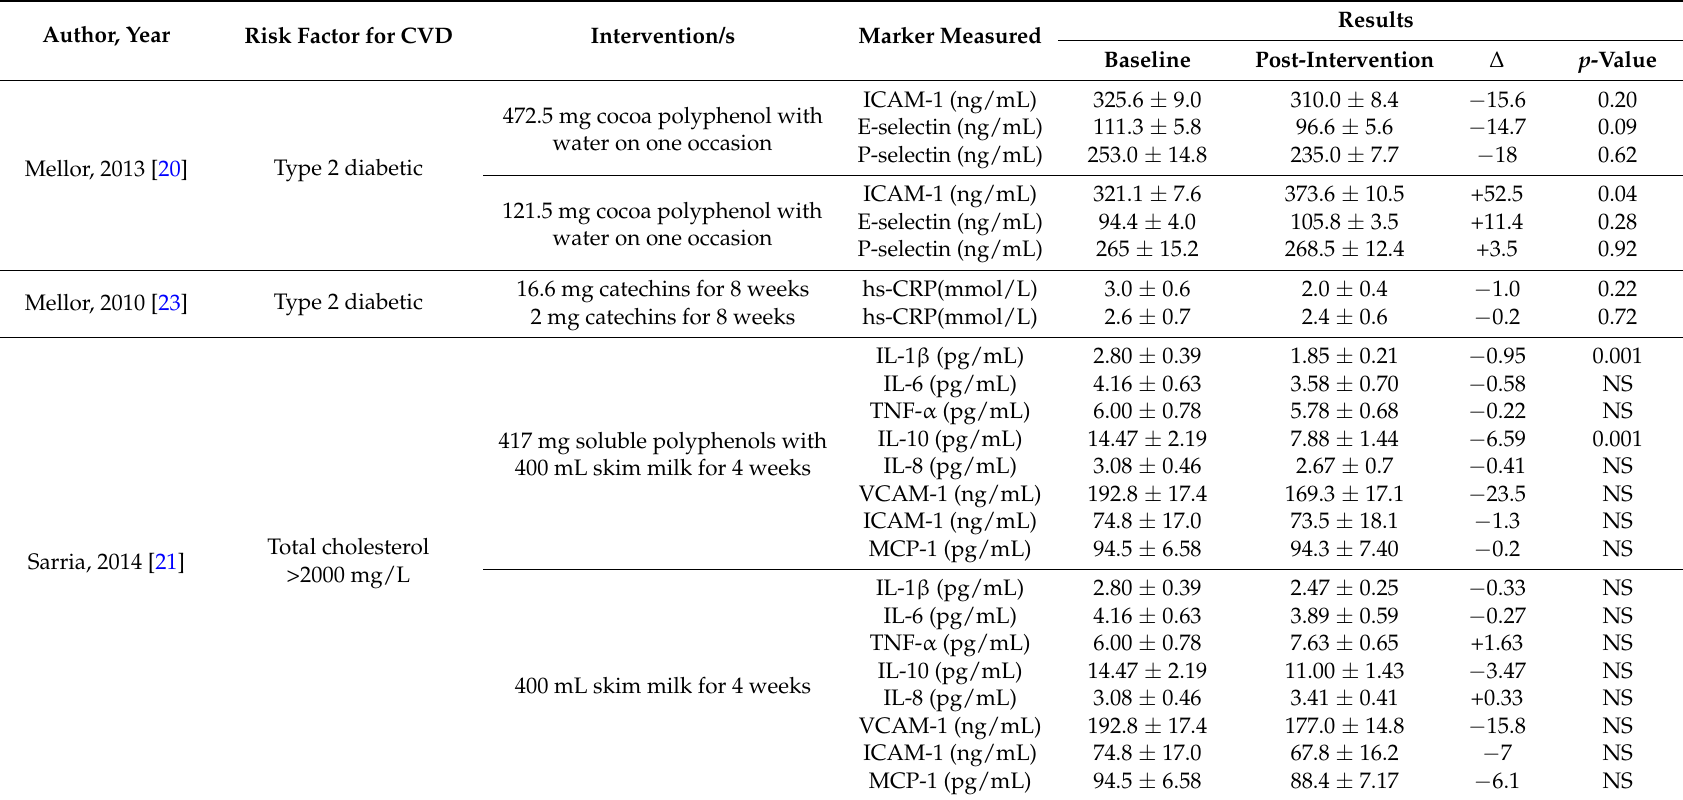
Table 4. Effect of cocoa polyphenols on inflammatory markers at baseline and